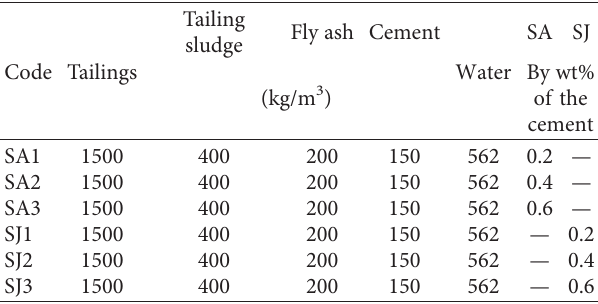
Table 4: Mixture proportions for the AEACPB.